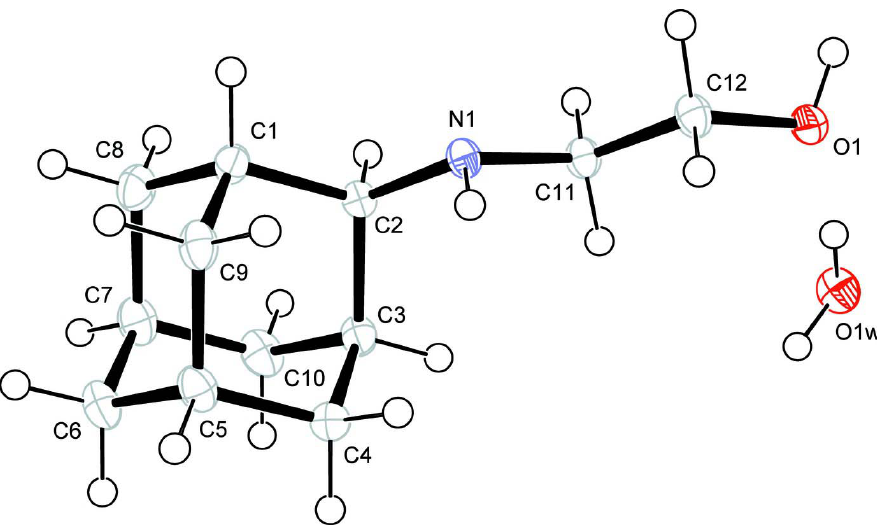
Figure 1 The ORTEP (Farrugia, 1997) diagram of the title compound showing the displacement ellipsoids for non-hydrogen atoms at the 50% probability level.